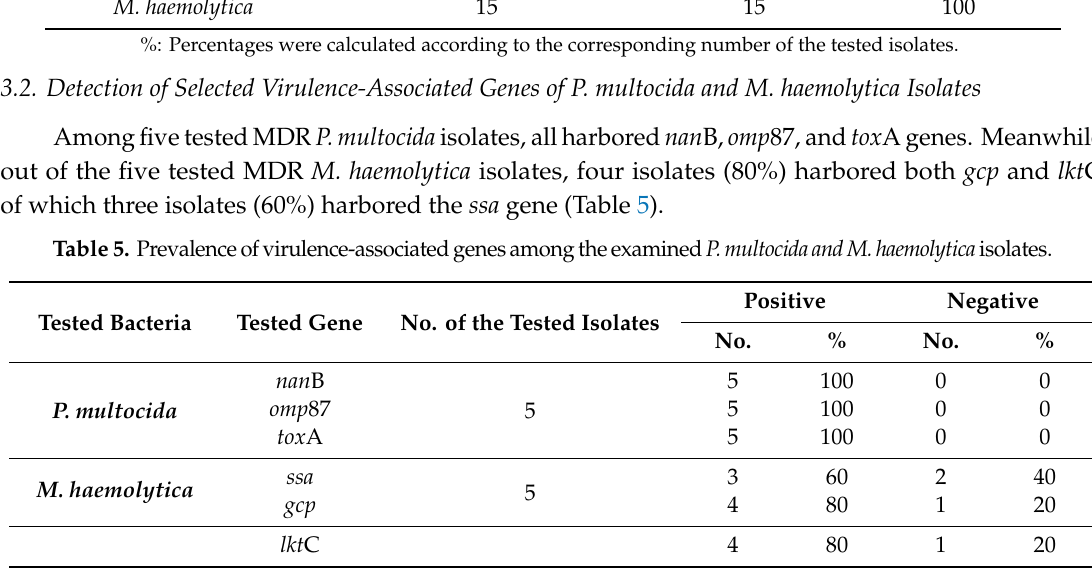
Table 4. Results of PCR as a confirmatory identification of P. multocida and M. haemolytica isolates. Tested Bacteria No. of the Tested Isolates